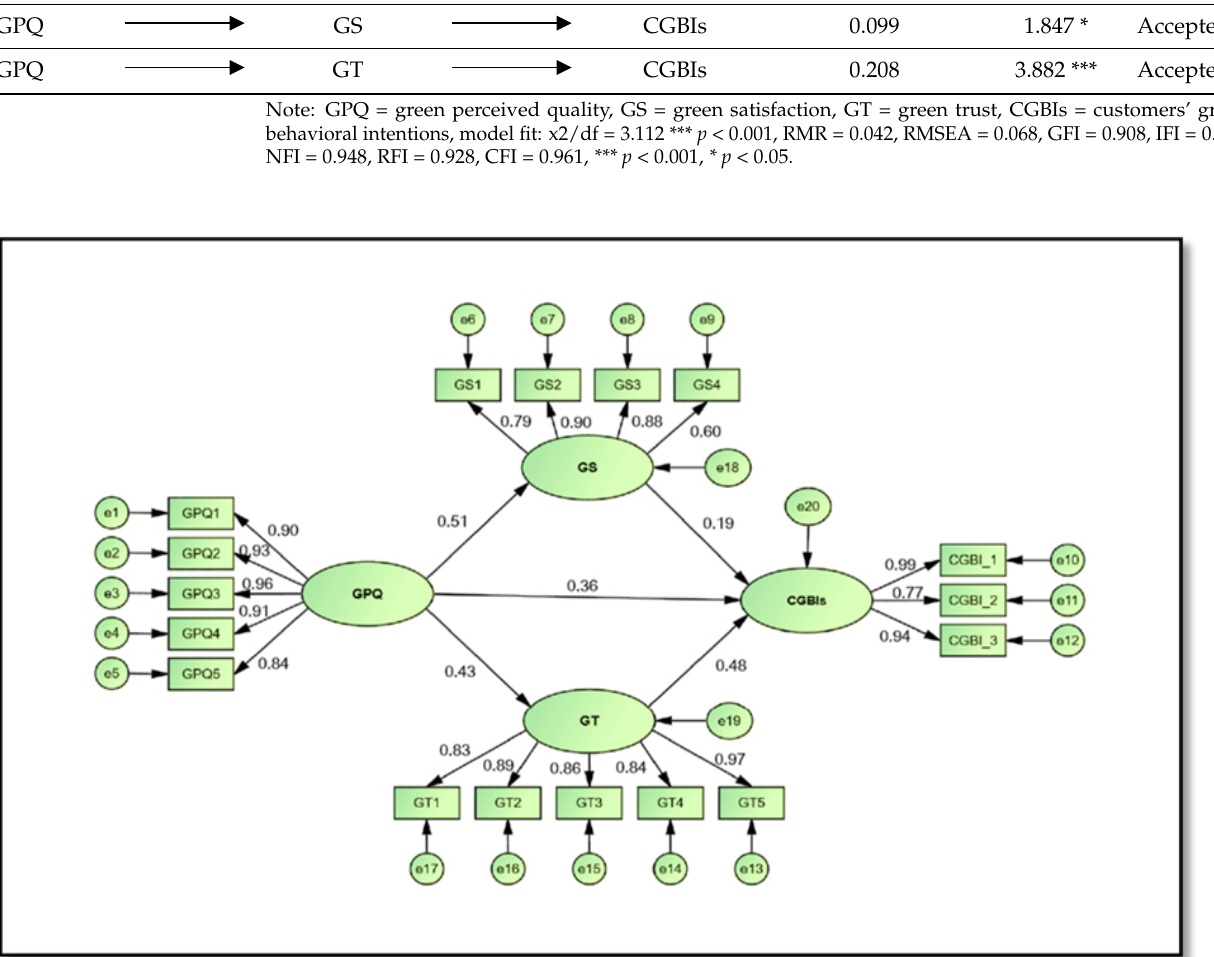
Table 5. Structural Parameter Estimates.